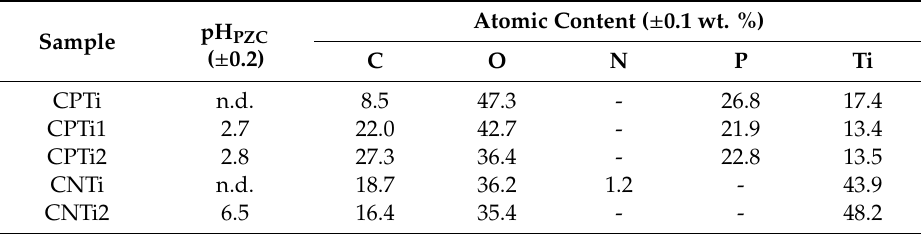
Table 1. Surface composition of Ti-impregnated cellulose and its carbon derivatives determined by X-ray photoelectron spectroscopy (XPS) and measurements of pH PZC